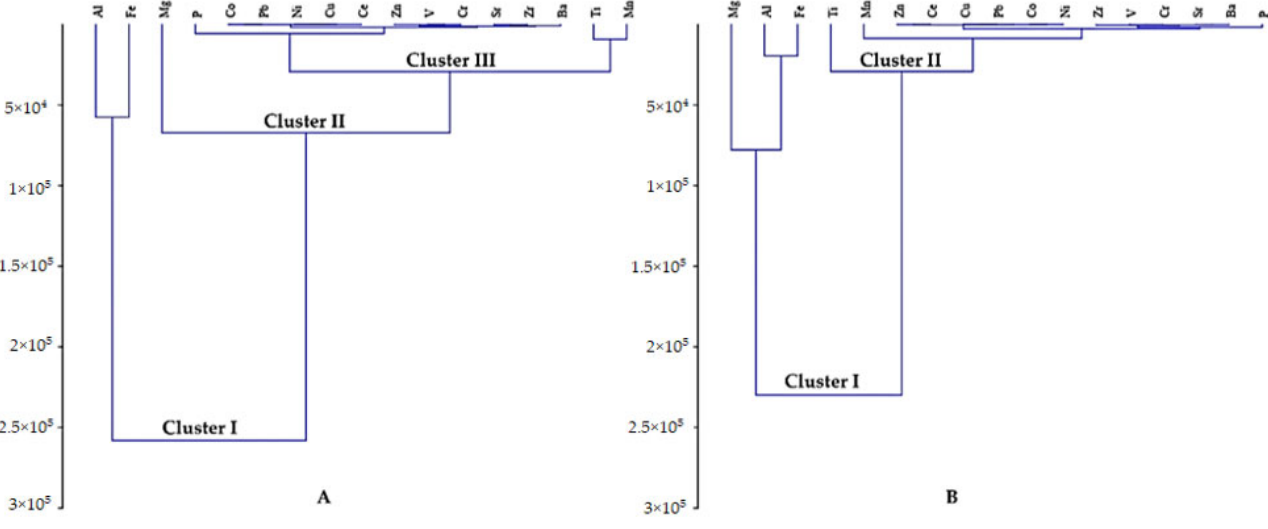
Figure 2. A dendrogram presented the elements clusters in sediment samples of ( A ) estuary and ( B ) littoral shelf. ( B ) littoral